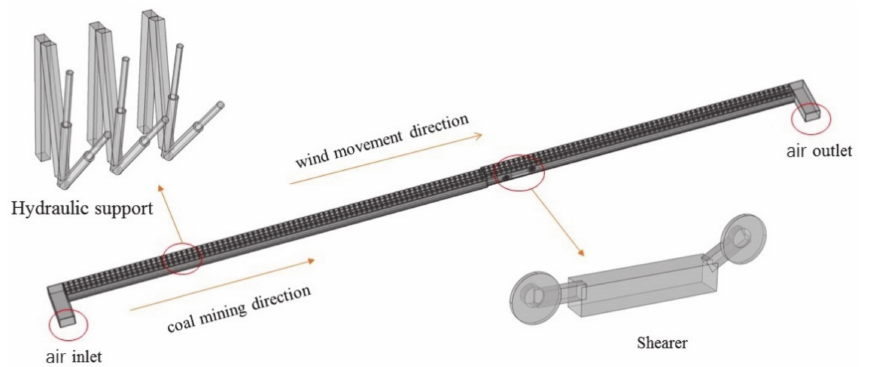
Figure 1. Geometric